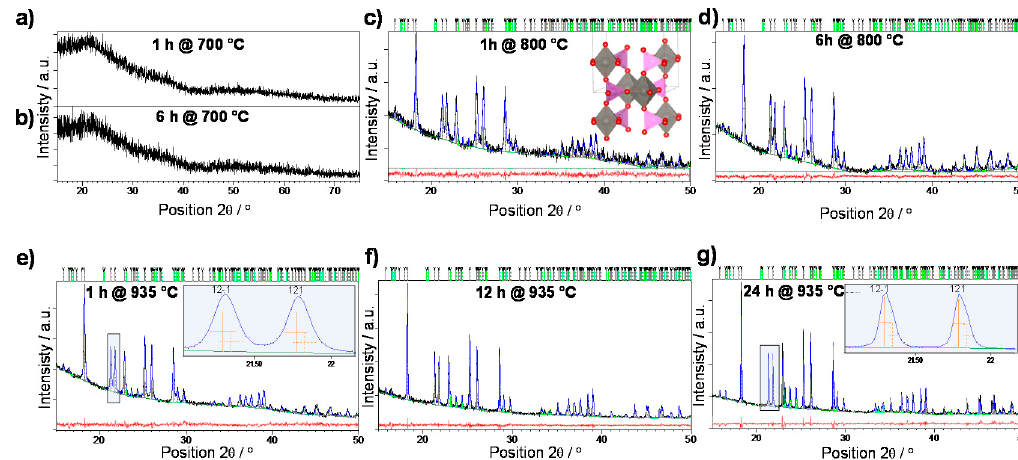
Figure 1. Rietveld refinements of glass pellet samples crystallized for ( a ) 1 h at 700 ◦ C, ( b ) 6 h at 700 ◦ C, ( c ) 1 h at 800 ◦ C, ( d ) 6 h at 800 ◦ C, ( e ) 1 h at 935 ◦ C, ( f ) 12 h at 935 ◦ C and ( g ) 24 h at 935 ◦ C. Experimental data are given by black line, the calculated pattern is shown in blue, while the red line represents the di ff erence curve. Grey vertical marks show the positions of di ff raction lines belonging to W 2 O 3 (PO 4 ) 2 phase while the positions of WO 3 lines are given as green vertical marks. Inset in ( c ) shows the structure of dominant phase, W 2 O 3 (PO 4 ) 2 ; WO 6 octahedra are shown in grey while PO 4 tetrahedra are pink. The insets in ( e , g ) demonstrate the di ff erences in the integral line breadths caused by prolonged crystallization period.